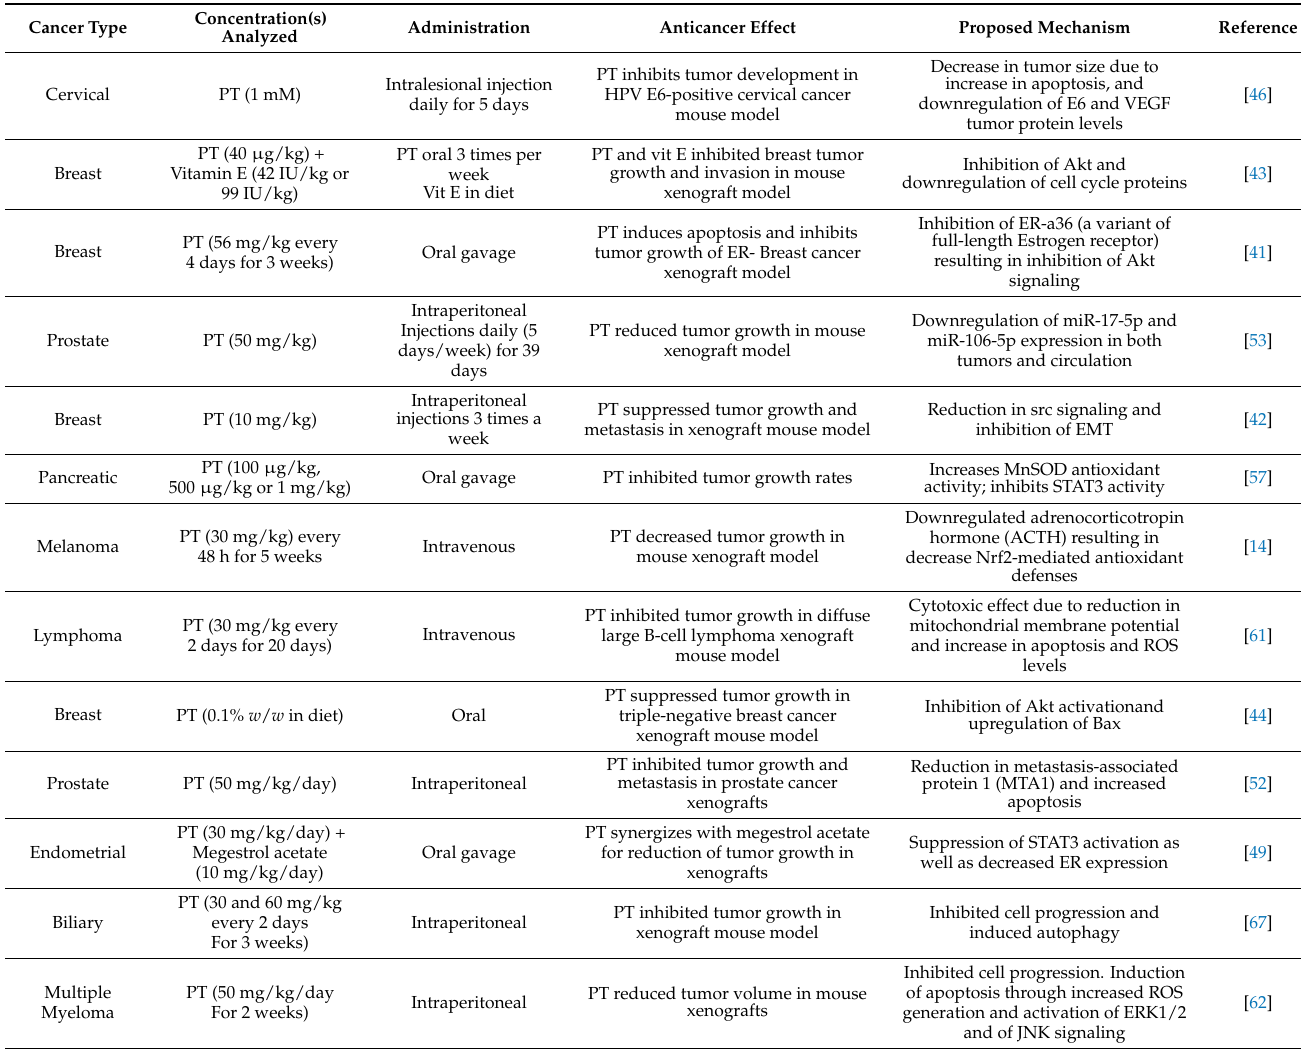
Table 2. PT and cancer: in vivo evidences. AOM: azoxymethane; HCC: hepatocellular carcinoma; TPA: 12-O-